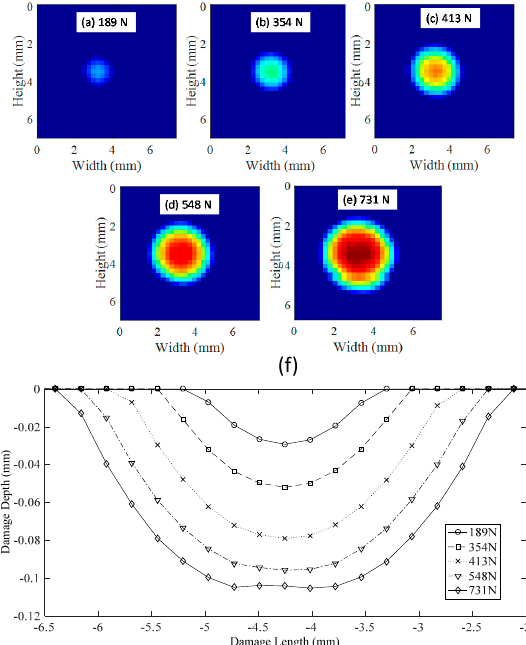
Figure 14. Damage geometry in the contact region during the unloading path for a 2 mm-thick specimen. ( a – e ) Geometry of the contact damage region for different displacement steps (20%, 40%, 60%, 80% and 100% cylinder displacement with a maximum of − 2 mm) during the loading path for a 2 mm-thick specimen. ( f ) Profiles of the contact damage depth for the different displacements steps.